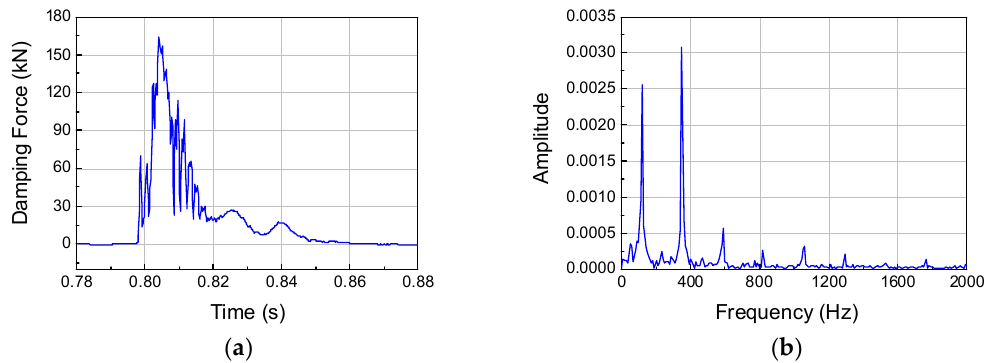
Figure 5. Measured damping force in the time and frequency domains: ( a ) Measured damping force in the time domain; ( b ) Measured damping force in the frequency domain.